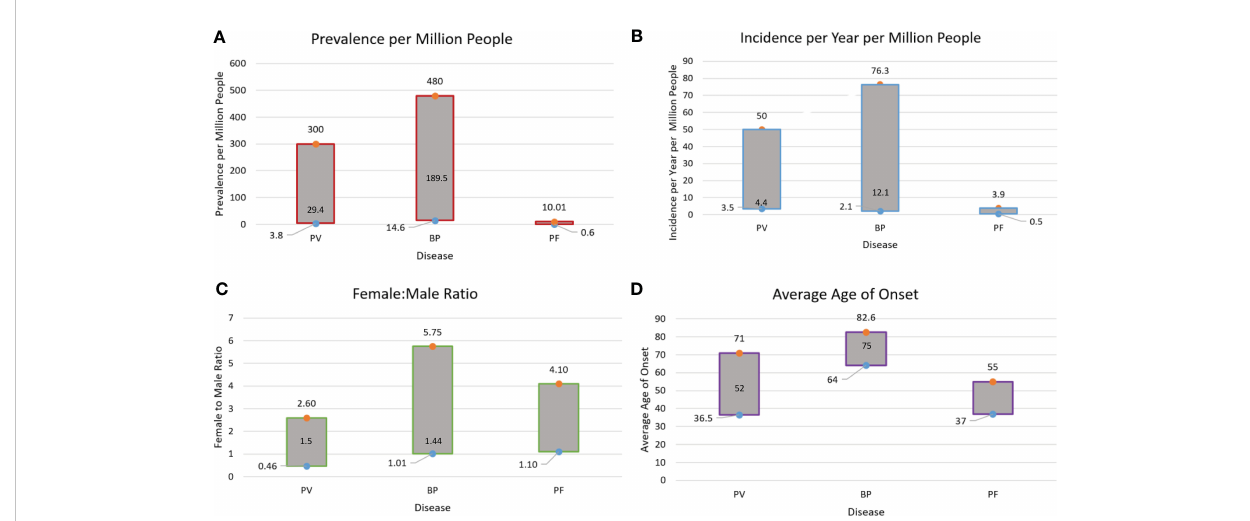
FIGURE 7 Summary of Prevalence (A) , Incidence (B) , Gender Ratio (C) , and Age of Onset (D) Ranges for PV, BP and Pemphigus Foliaceous (PF). Data on PF incidence and prevalence are sparse in the literature. This is due to the fact that PF is seldomly studied independently, while studies that report on Pemphigus as a singular disease category (including PV and PF) do not provide data individually on disease subtypes. The median values for age of onset, gender ratio, prevalence, and incidence in PV and BP are noted within the